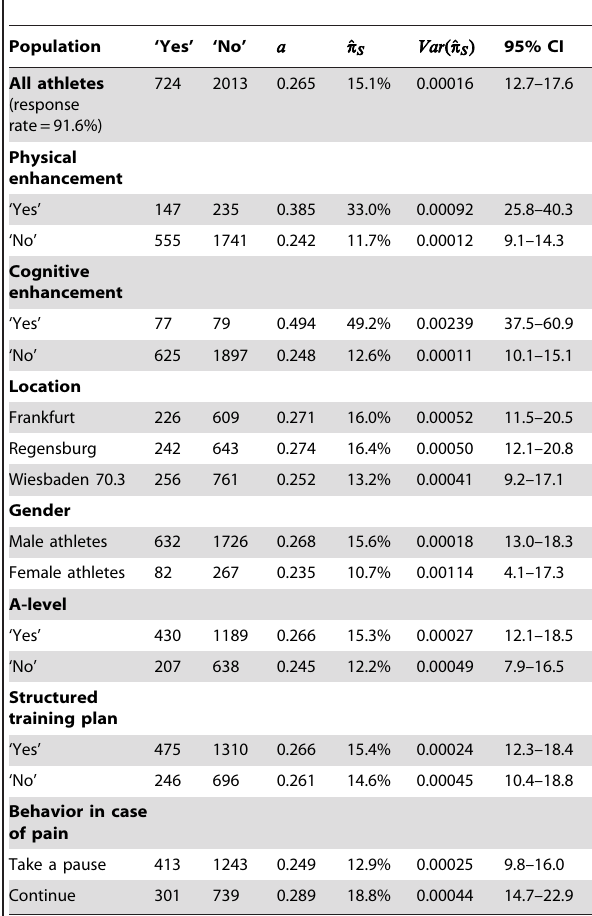
Table 10. Estimated 12-month prevalence for cognitive doping by using